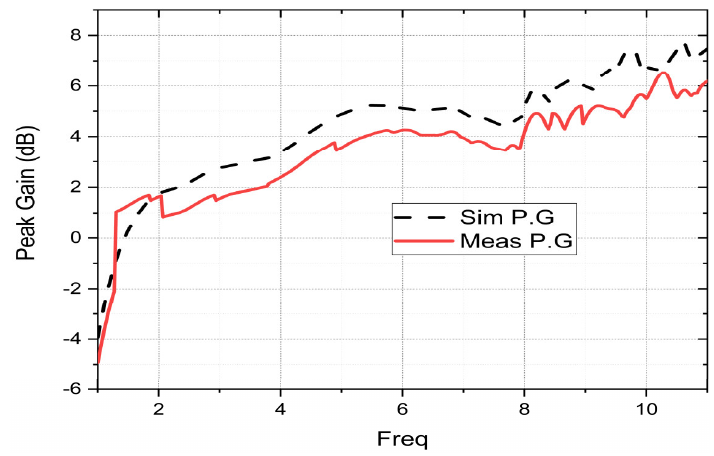
Figure 10. Peak gain of the suggested patch.